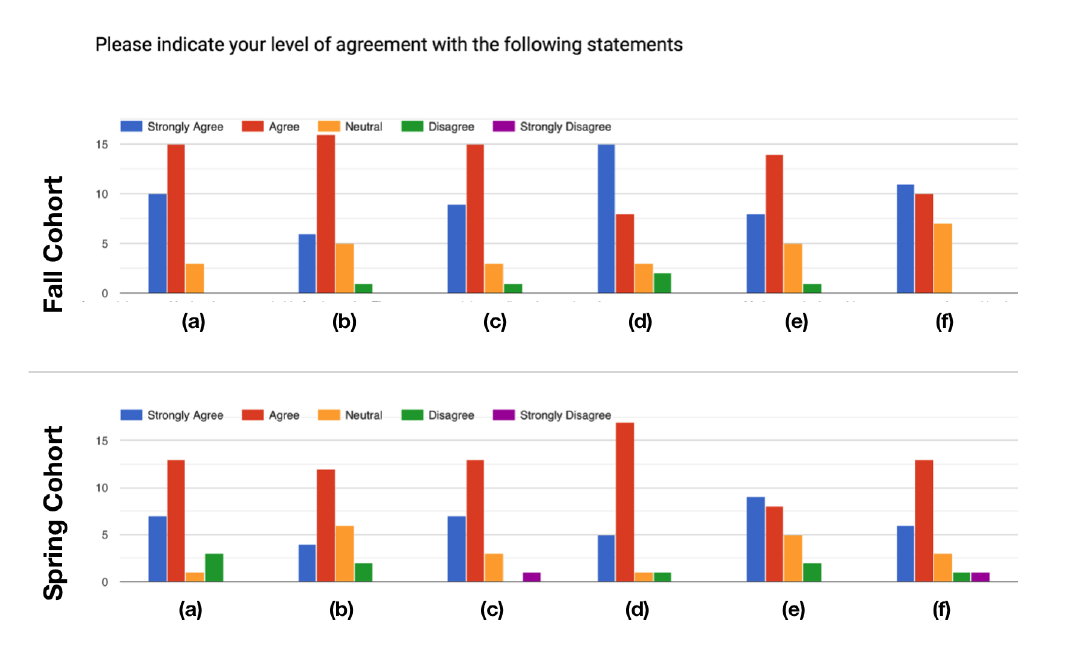
Figure 3. General questions about the course on the opinion